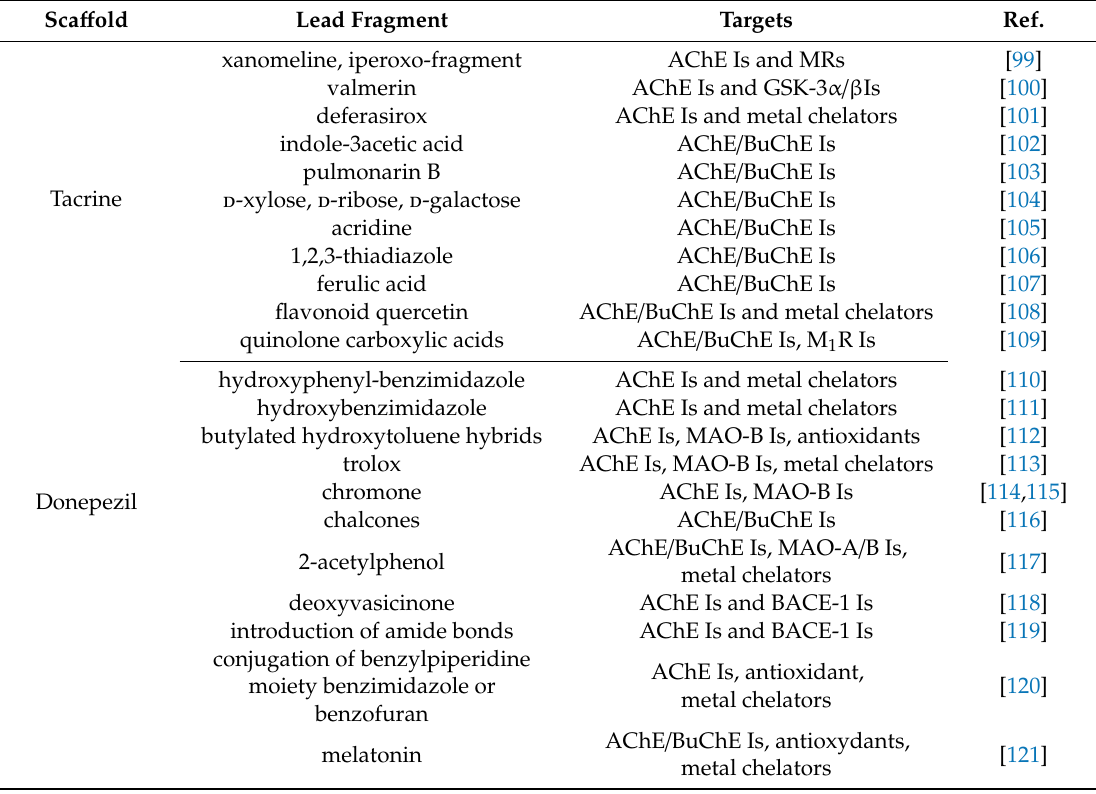
Table 2. Examples of MTDLs based on tacrine and donepezil sca ff